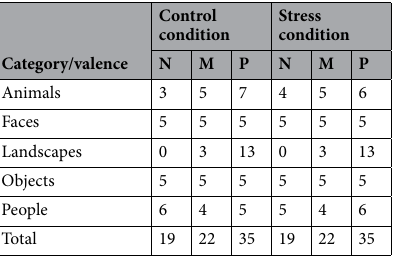
Table 1. Numbers of images used in the NAPS BE, by valence and category. N negative-valence image, M medium-valence image, P positive-valence